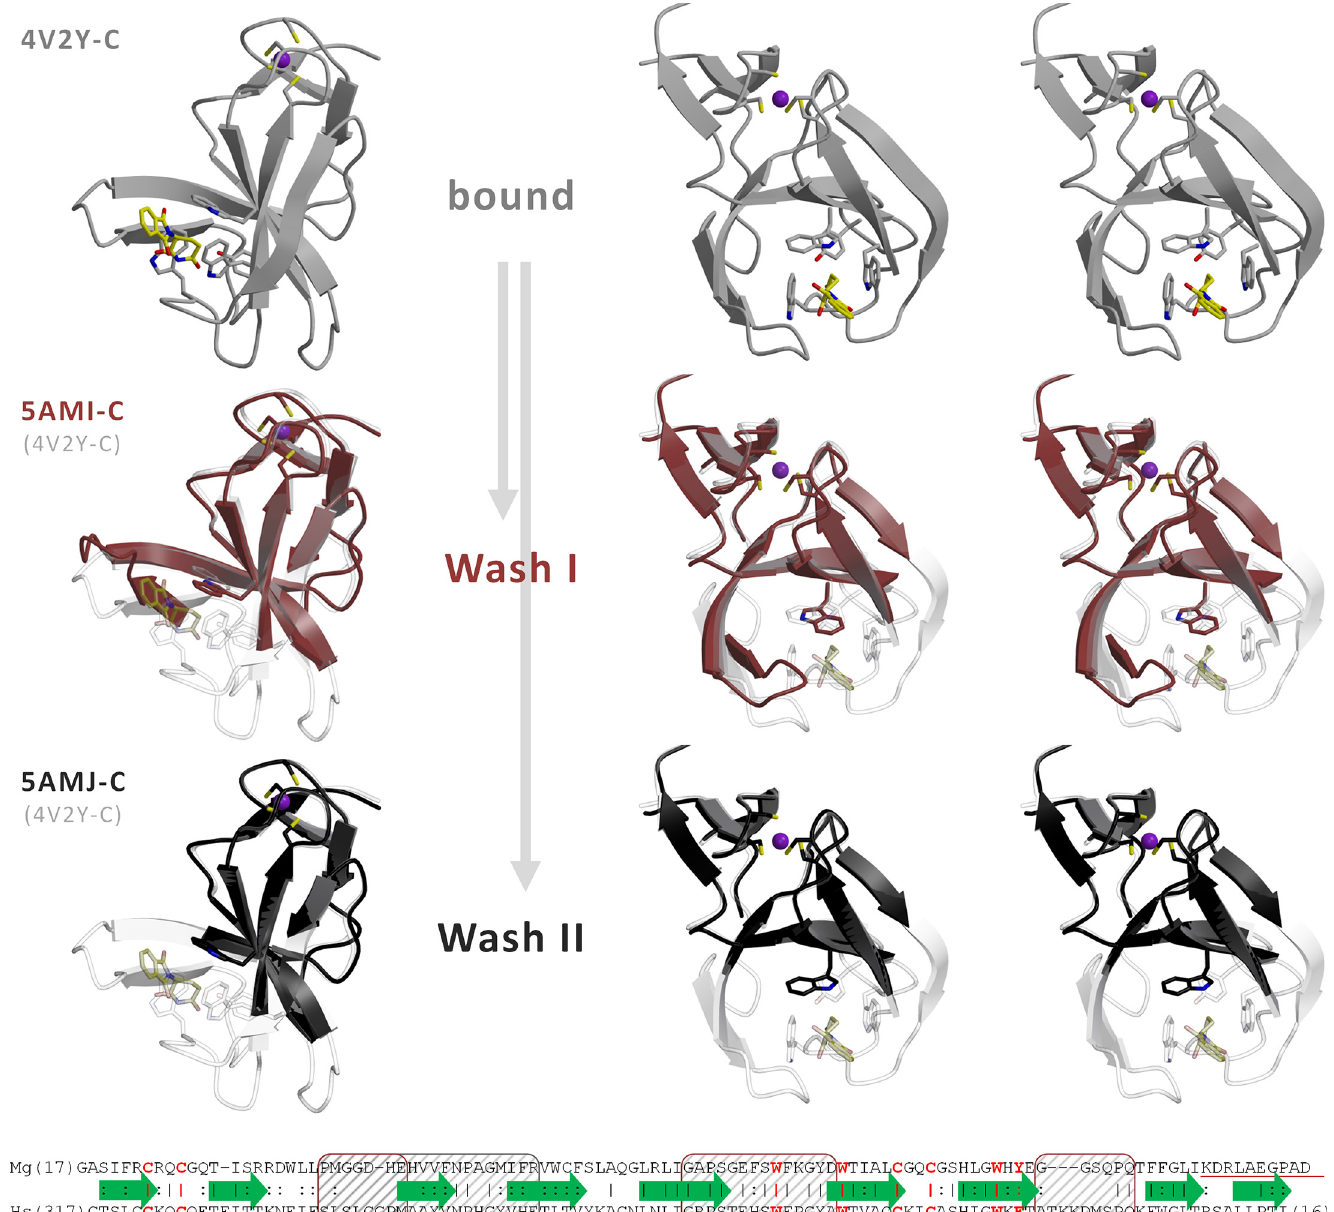
Fig 2. Partial unfolding of MsCI4 upon loss of thalidomide. Crystals of the orthorhombic crystal from two crystallization conditions were washed for 40 h in a solution without thalidomide. For the initial structure (grey) and both experiments, “ Wash I ” (brown) and “ Wash II ” (black), the monomer that had the ligand washed out (chain C) is depicted in two perspectives. Loss of ligand was accompanied by the unfolding of three regions. The structures after washing are overlaid with the initial structure in transparent. On the bottom, the sequence alignment of MsCI4 with human cereblon details the unfolded regions and indicates secondary structure elements. The unfolded regions are shaded. In “ Wash I ” , the unfolding of the first region is incomplete, so the hairpin formed by the 3 rd and 4 th β -strand is still folded, albeit shifted in position. The C-terminal segment deleted in the R419X mutant of human cereblon and the corresponding segment in MsCI4 are underlined. Key-residues are highlighted